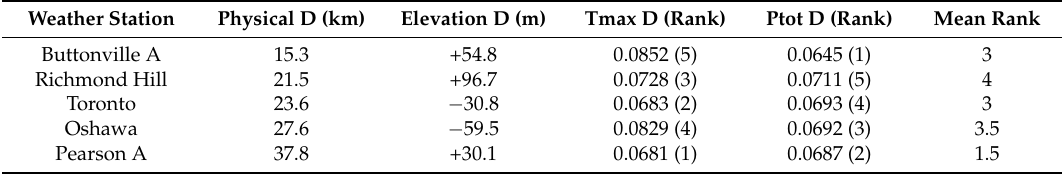
Table 1. Climatic Distance (D) for the Toronto Zoo (based on an analysis of observational data from 1977 to